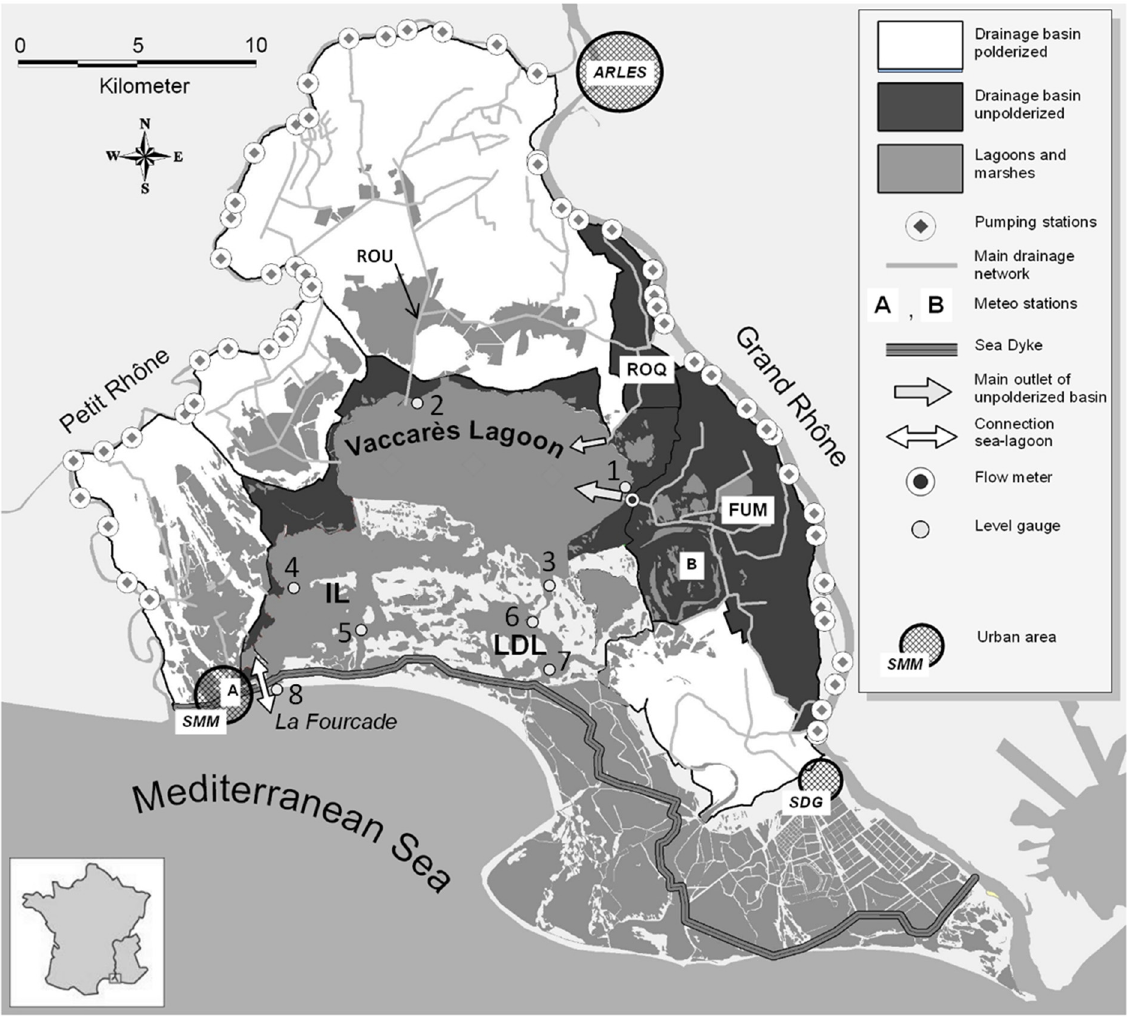
Figure 1. Map of the Ile de Camargue hydrosystem delimited by the two branches of the Rhône River (Petit Rhône and Grand Rhône). SMM and SDG are the towns of Saintes-Maries de la Mer and Salins de Giraud,